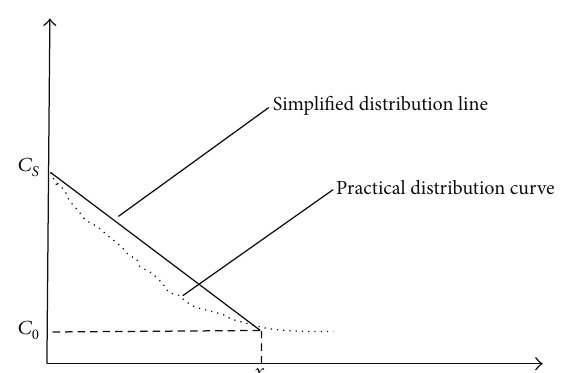
Figure 1: Schematic diagram of the simplified distribution of the concentration of sulfate